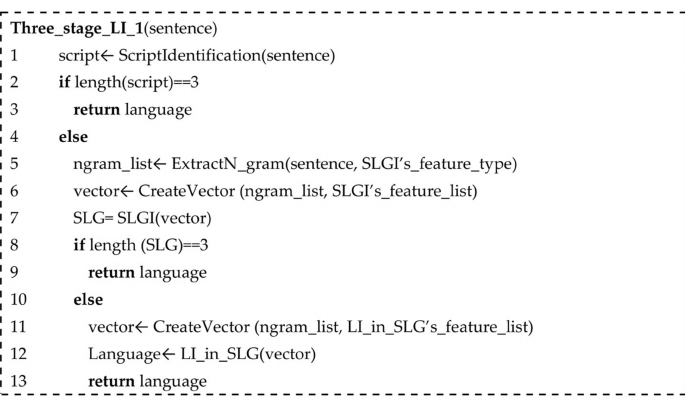
Figure 2. Pseudocode of three-stage